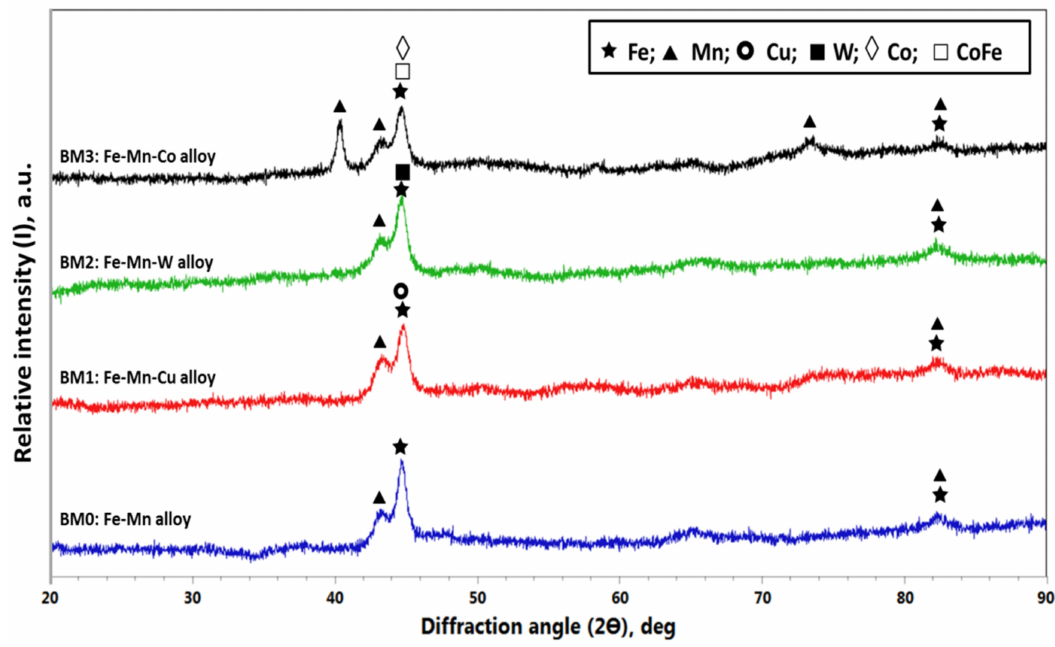
Figure 5. XRD results of MAed BM0, BM1, BM2, and BM3